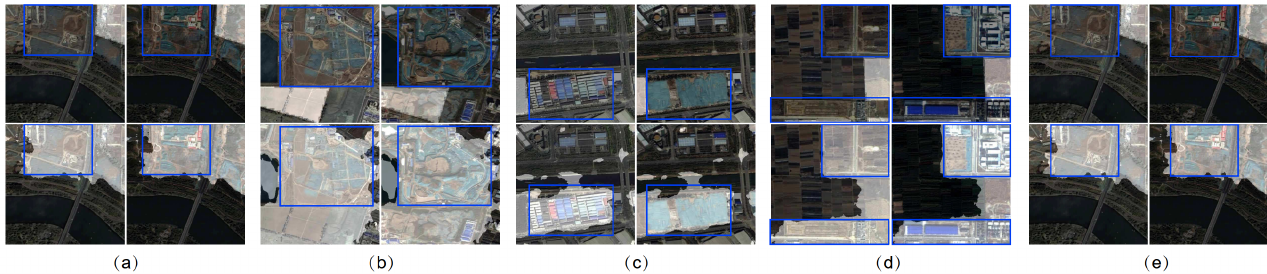
Figure 7. Qualitative change detection results. The top two images of ( a – e ) are the image pairs covered with the real labels, while the bottom two are the image pairs masked by the predicted labels.